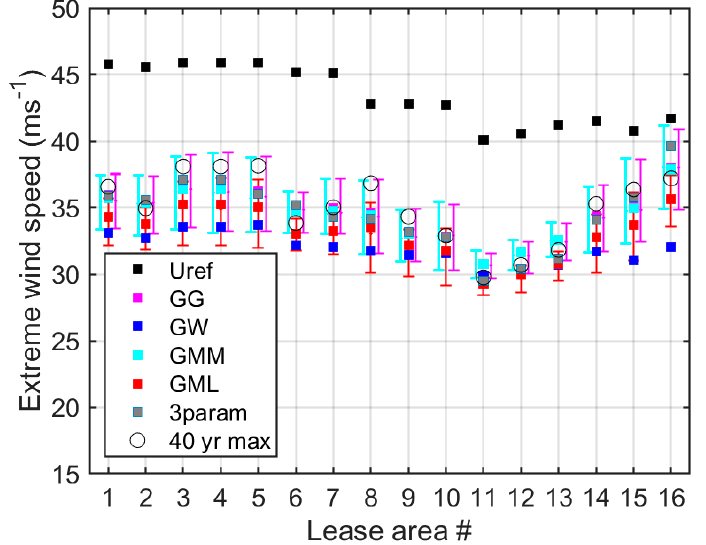
Figure 5. Comparison of U 50 for each LA from the different methods (the colored symbols). The open symbol shows the 40-year maximum wind speed U 40 from the ERA5 data (Table S1). The error bars show the maximum and minimum wind speed from the 95th confidence interval estimated using boot-strapping for GML and GG/GMM (the latter are offset in the horizontal to aid clarity). U 50 at 100 m a.s.l. across the 16 LA as derived using ERA5 range from 30 to 40 ms −